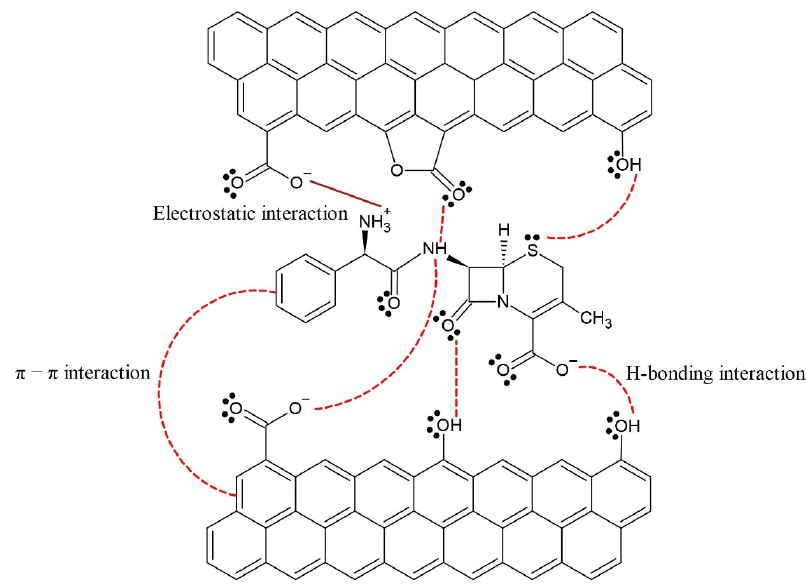
Figure 7. Possible interactions during CPX removal at pH: 4–5.